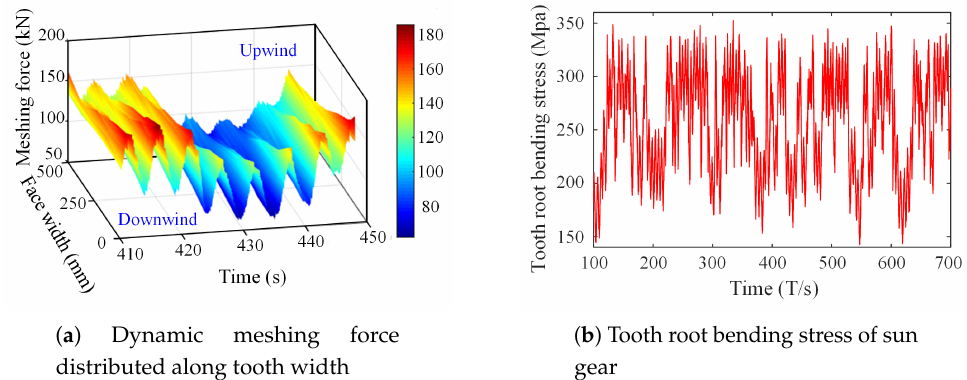
Figure 11. Calculation of tooth root bending stress of sun gear of 1st stage.